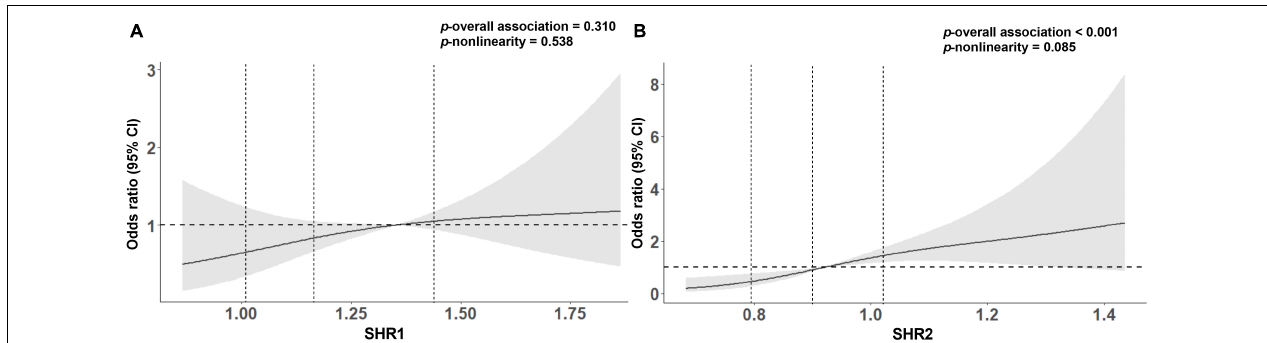
FIGURE 2 | Association between (A) SHR1 defined as [admission random blood glucose (RBG) (mmol/L)]/[HbA1c (%)], (B) SHR2 defined as [fasting blood glucose (FBG) (mmol/L)]/[HbA1c (%)] and poor clinical outcome on 3-month using restricted cubic splines with 3 knots (at the 10th, 50th, and 90th percentiles). The model was adjusted for age, sex, current smoking, hyperlipidemia, atrial fibrillation, prior stroke, systolic blood pressure (SBP), and NIHSS at admission. The solid line indicates the odds ratio while the shadow indicates 95% CIs. The vertical dashed lines indicate the 1st, 2nd, and 3rd quartiles of SHR. The horizontal dashed line is the reference line (odds ratio = 1). The reference of SHR1 was 1.35, and the reference of SHR2 was 0.92.